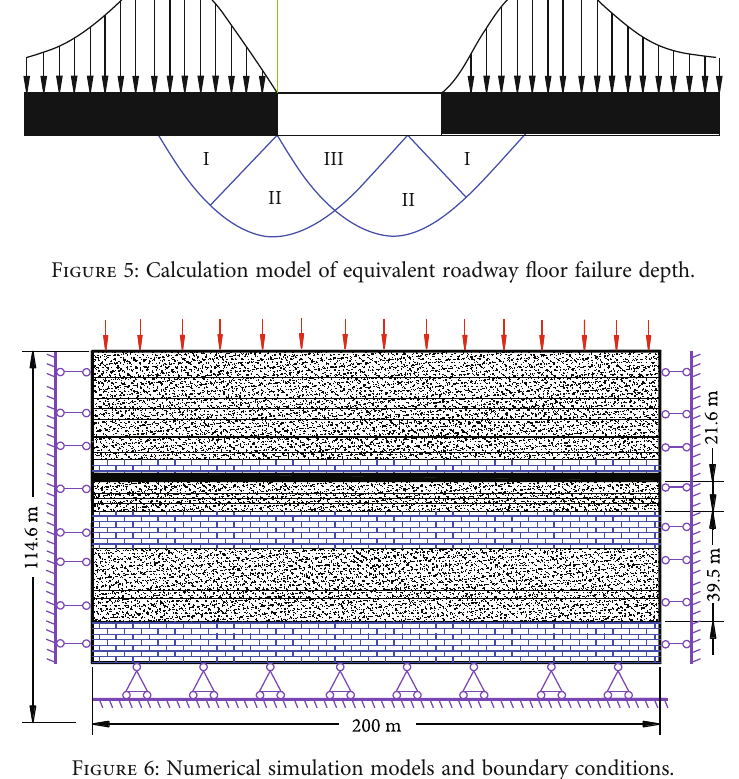
Figure 6: Numerical simulation models and boundary